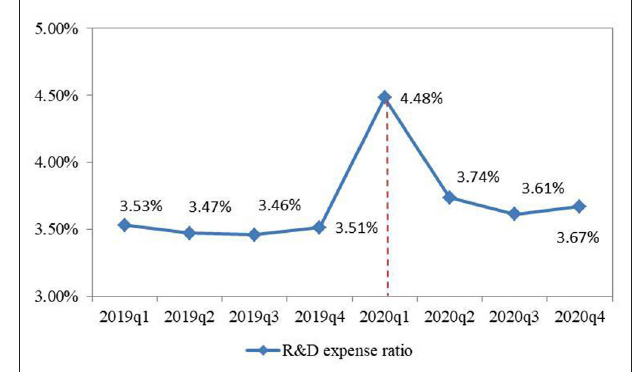
FIGURE 1 | R&D expense rate of listed companies from 2019 to 2020.